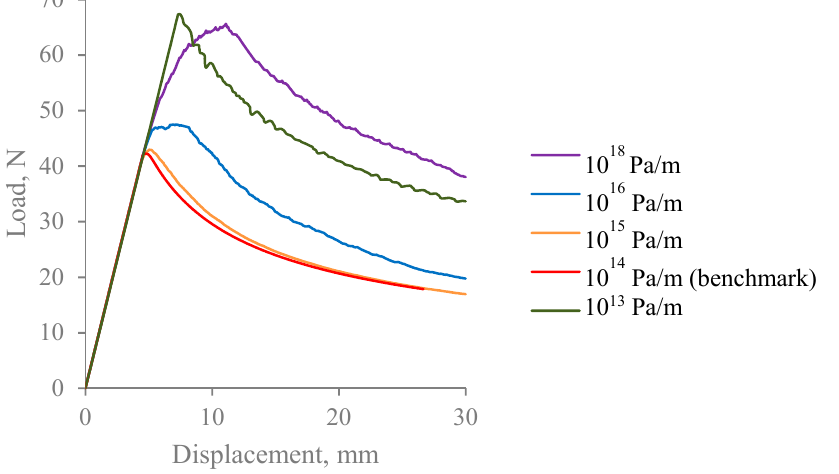
length of the beam; ( b ) along the width of the beam; ( c ) in the thickness direction.